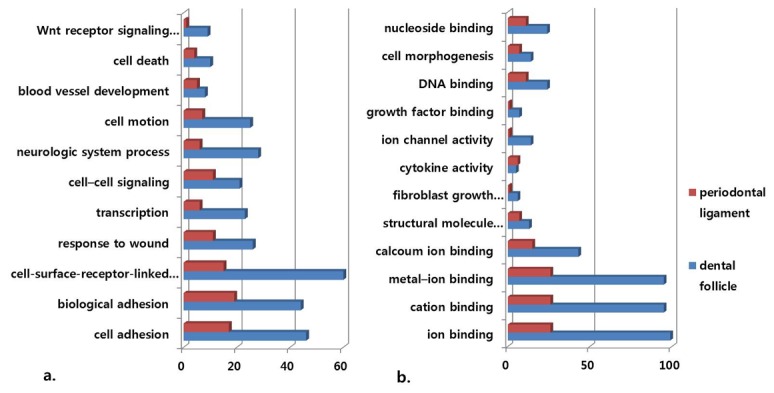
Gene-ontology analysis of the periodontal ligament(PDL) and the dental follicle.a. Main categories of genes expressed specifically in the dental follicle and periodontal ligament (PDL) tissues on the basis of their biological processes. b. Main categories of genes expressed specifically in dental follicle and PDL tissues on the basis of their molecular function (x-axis: number of involved genes, F-statistic p<0.05).